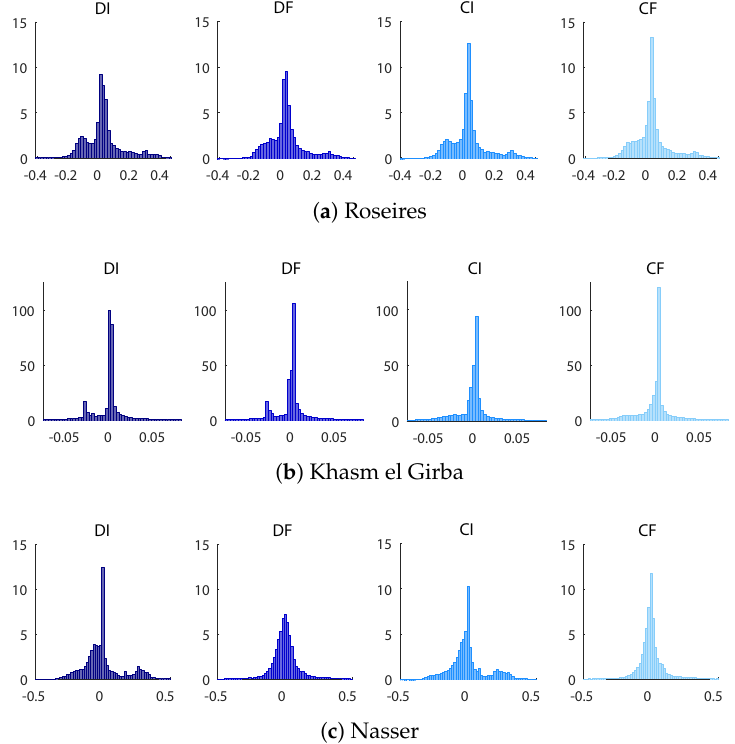
Figure 7. Error distribution for the identified control laws. Errors are computed as the difference between targets and model outputs and normalized between − 1 and